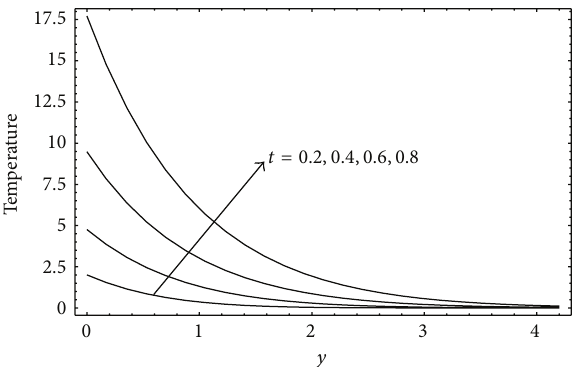
Figure 13: Temperature profiles for different values of Pr when 𝑡 = 0.2, 𝑅 = 5 , and 𝛾 = 0.01